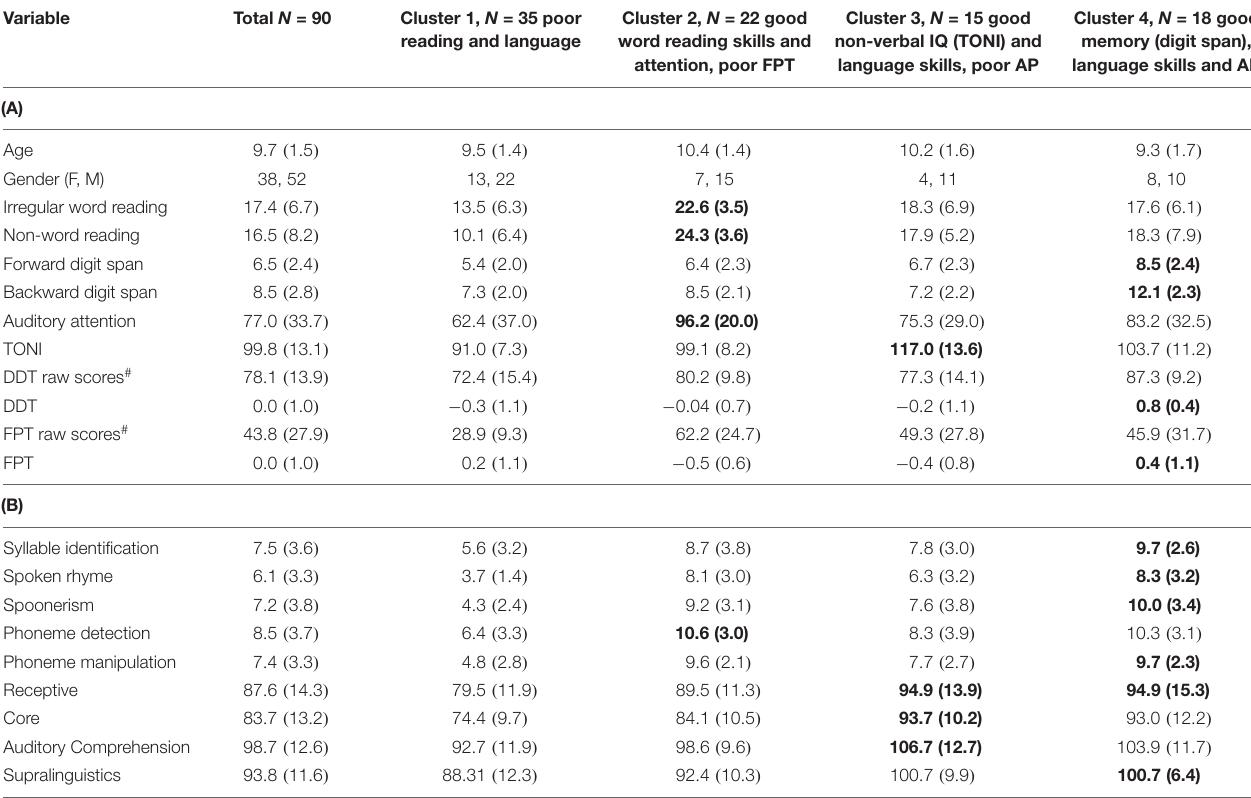
TABLE 4 | (A) Demographics and means (and standard deviation) of participants within each cluster on all skills; (B) means (and standard deviation) of participants within each cluster on phonological processing and language. Variable Total N = 90 Cluster 1, N = 35 poor